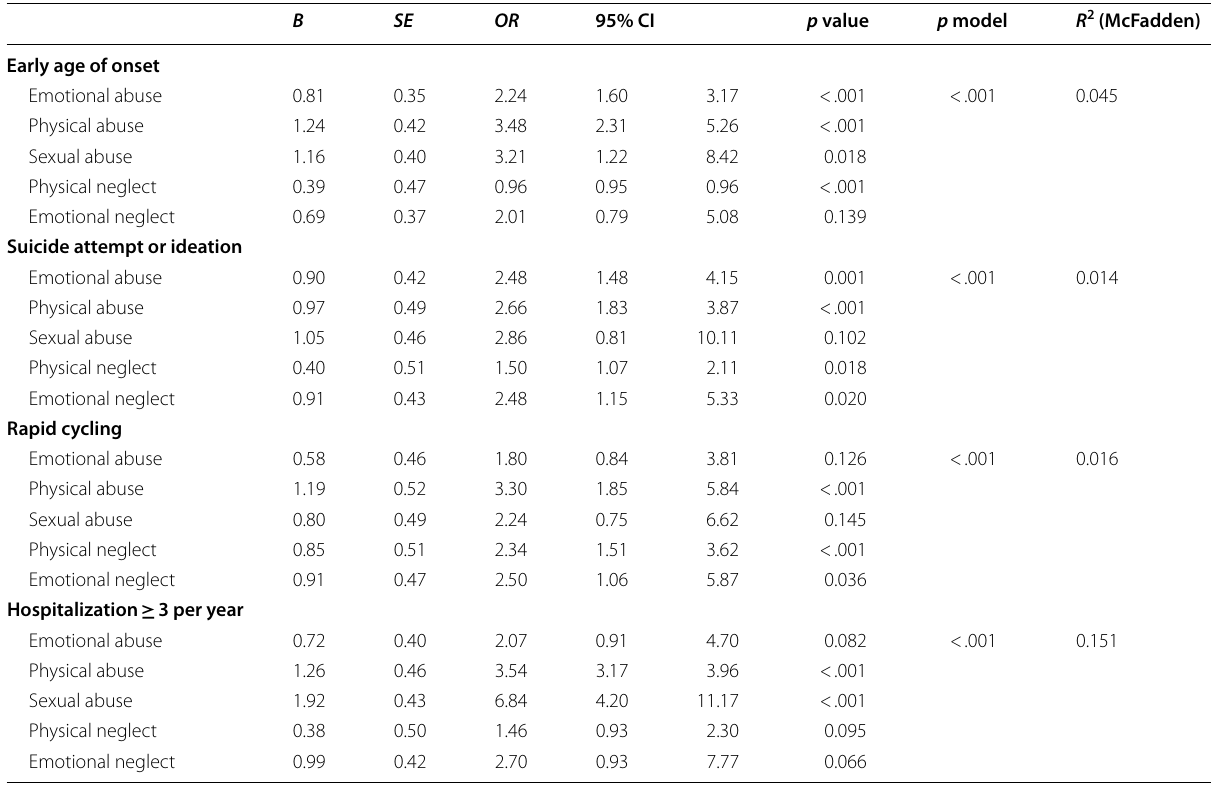
A robust logistic regression model clustered by case–control groups and adjusted by age, gender, marital status, socioeconomic status and alcohol use/abuse B regression coefficient, SE Standard Error, OR Odds Ratio, CI Confidence Interval, R 2 Adjusted